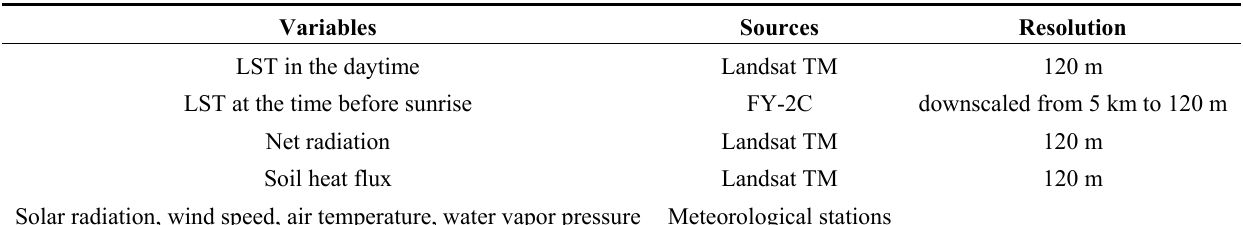
Table 1. Variables and the sources used in the study. FY-2C, Fengyun Meteorological